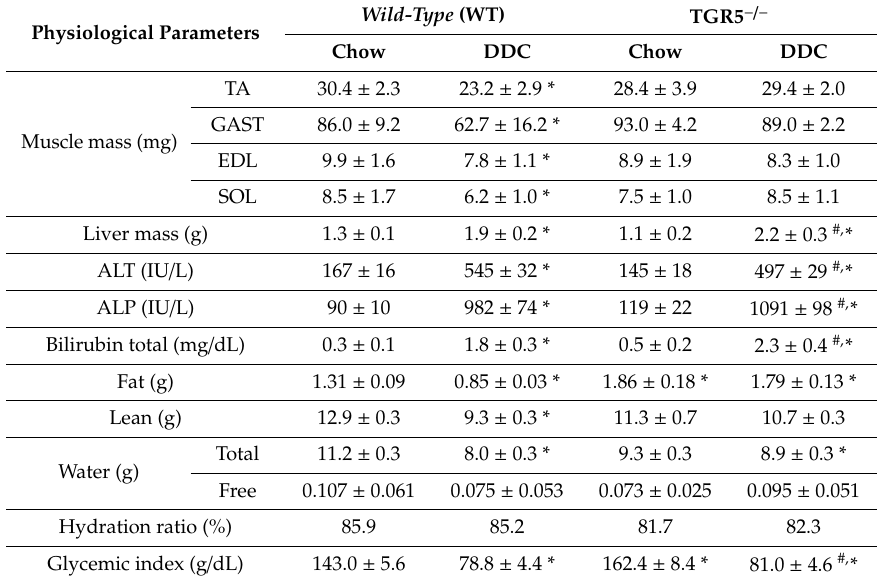
Table 1. Physiological parameters in mice with DDC-induced chronic liver disease (CLD). Wild-Type Physiological Parameters